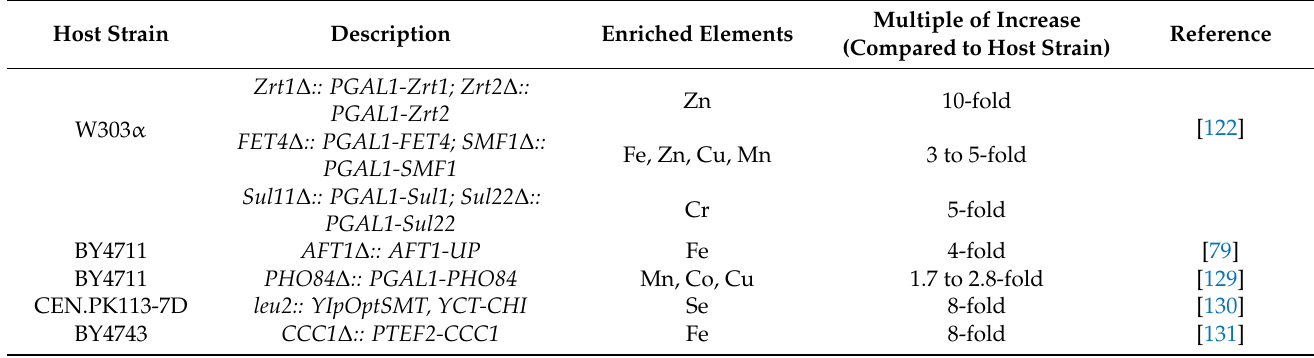
Table 3. Metabolic engineering to enrich trace elements by S. cerevisiae . Multiple of Increase Host Strain Description Enriched Elements (Compared to Host Strain)